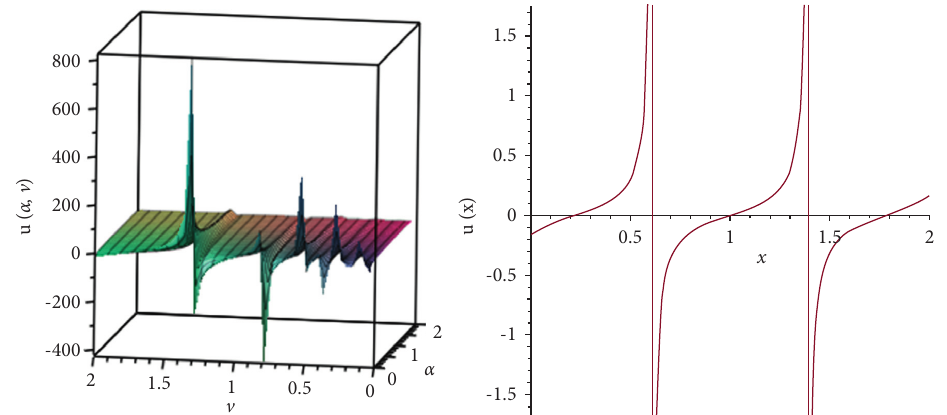
Figure 2: 3D plot of solution U